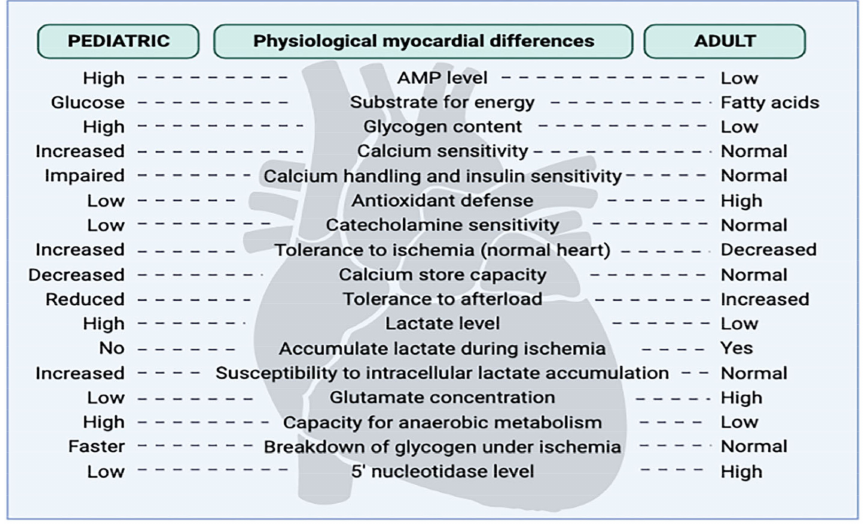
Figure 1. Differences in the pediatric and adult